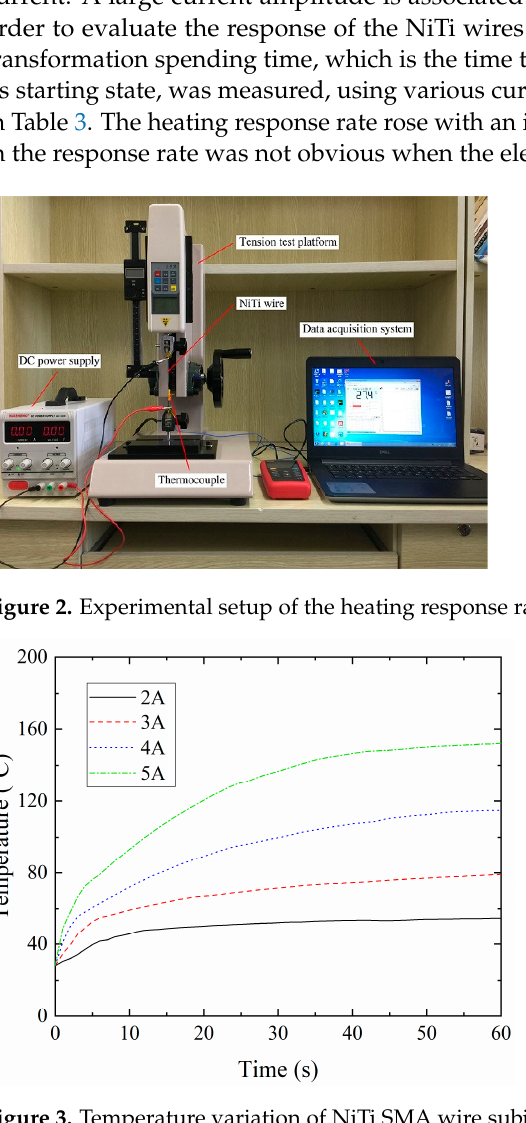
Figure 2. Experimental setup of the heating response rate tests.